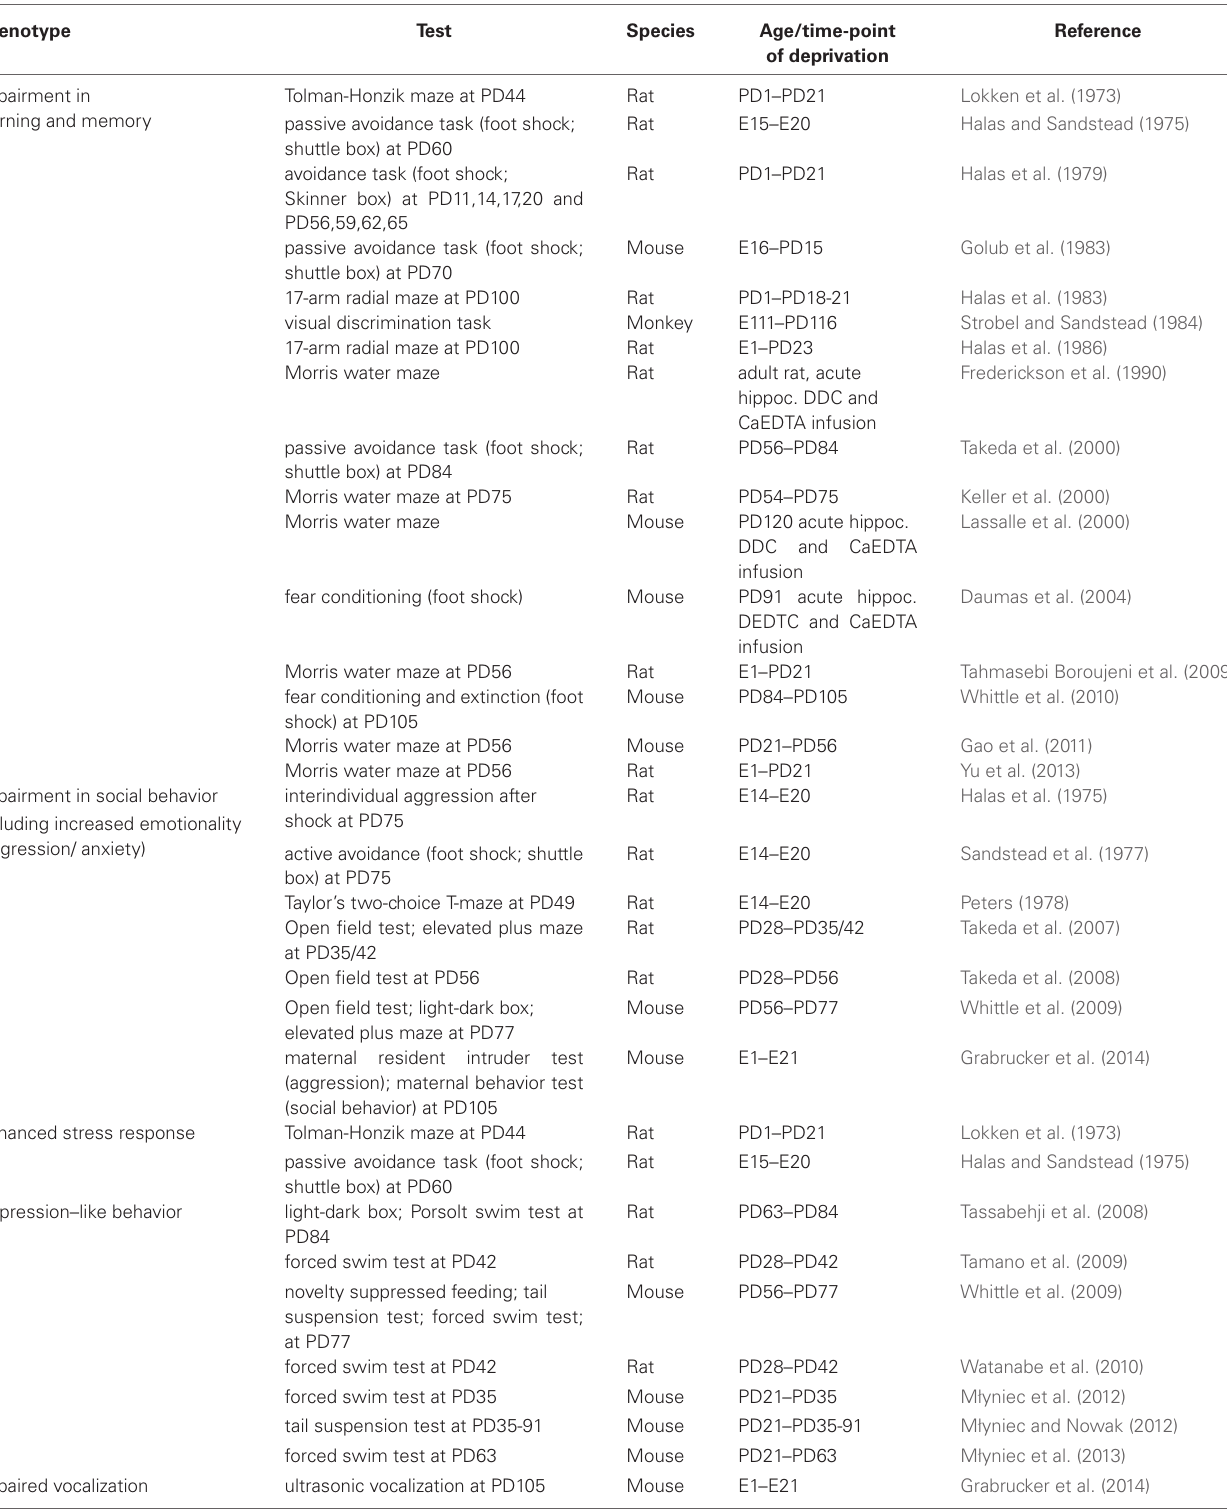
Table 1 | Summary of behavioral studies on zinc deficient animals